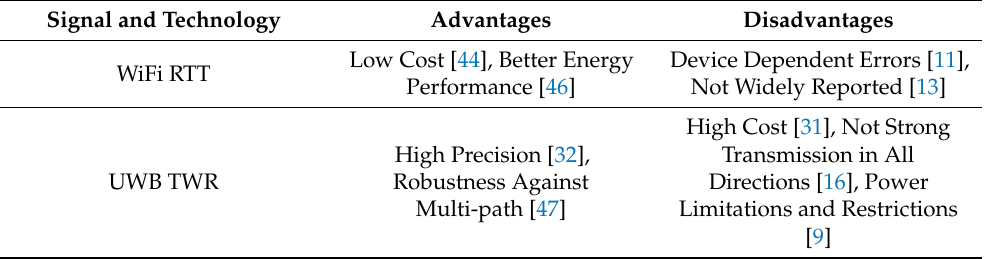
Table 1. The advantages and disadvantages of utilizing UWB and WiFi for positioning. Signal and Technology